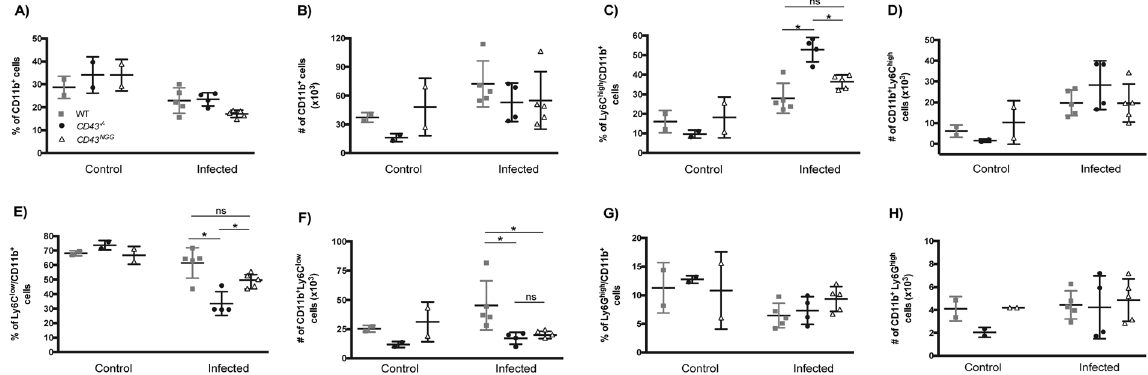
Figure 4. CD43 regulates the recruitment of phagocytes to the heart tissue of infected mice. Flow cytometry analysis of the frequency and absolute number of CD11b + ( A,B ), Ly6C high /CD11b + ( C , D ), Ly6C low /CD11b + ( E , F ) and Ly6G + /CD11b + ( G , H ) in the heart tissue of control (non-infected) or infected mice. Each cell population was analysed using the gating strategy presented in Fig. S3.